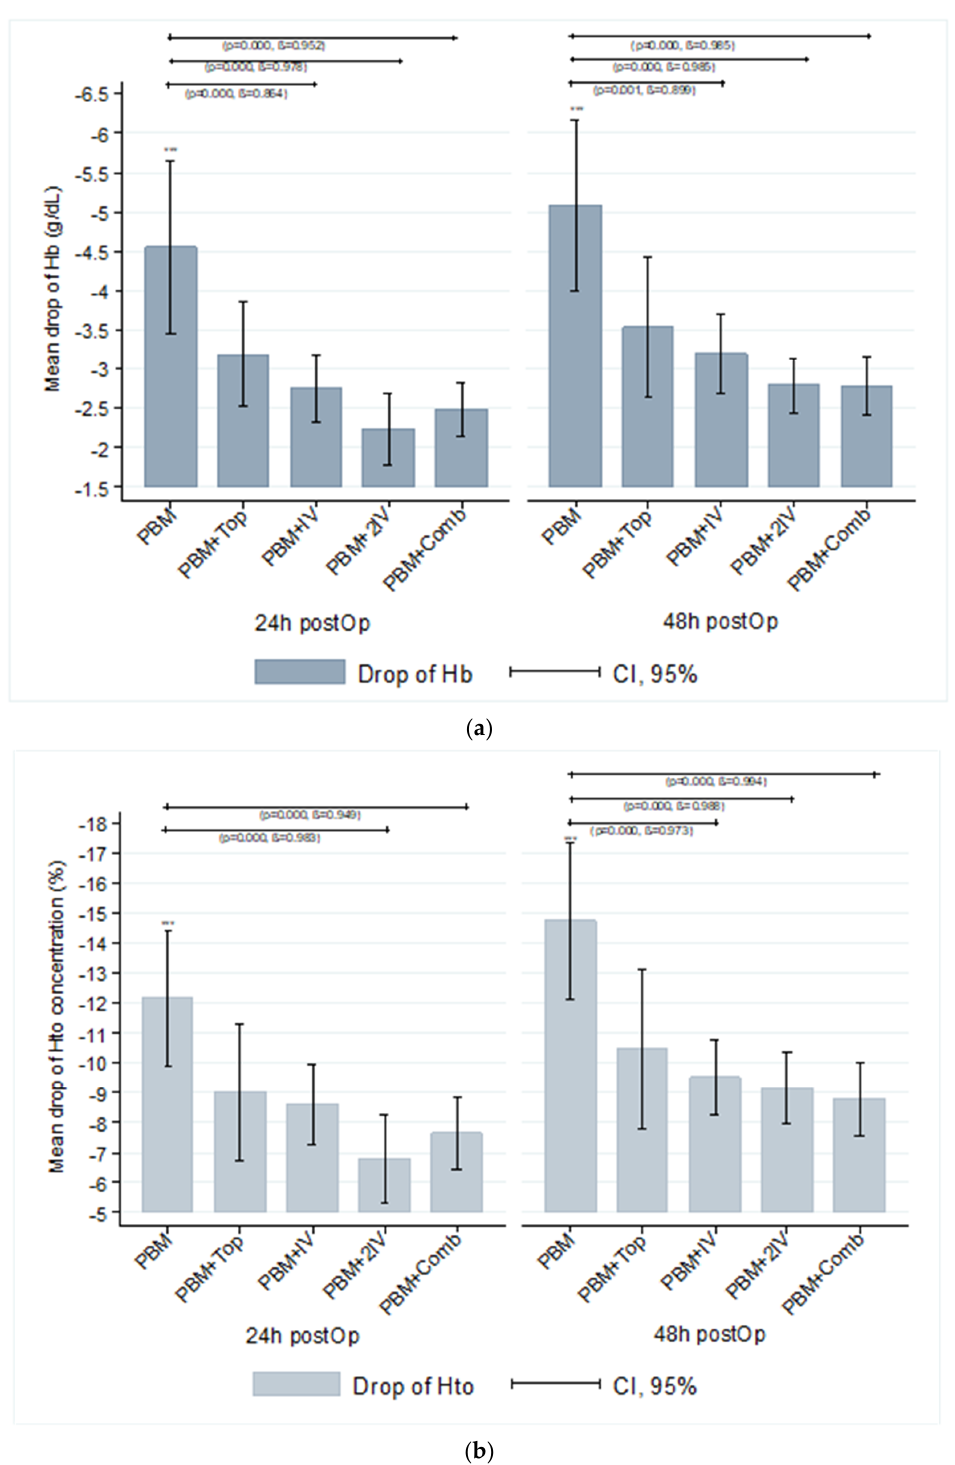
Figure 1. Laboratory differences at 24 and 48 h postoperative by group of treatment. ( a ) Drop of Haemoglobin concentration (g/dL); ( b ) Drop of Haematocrit concentration (%). *** The mean drop of haemoglobin concentration and haematocrit concentration shows differences (Kruskal–Wallis test) between the PBM group and other TXA groups. No differences were found in comparisons between each TXA group with other TXA groups ( p > 0.05, ß < 50%).